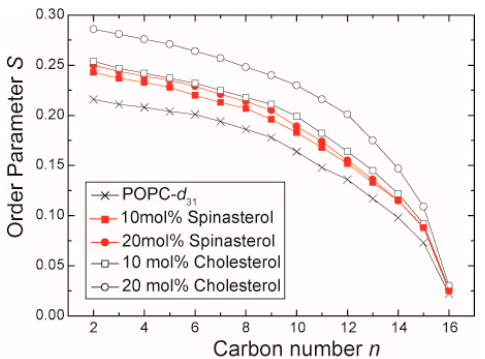
Figure 2. 2 H-NMR chain order parameter of the sn -1 chain of POPC- d 31 in the presence of 10 and 20 mol % α -spinasterol. For comparison, the chain order parameters of pure POPC- d 31 and POPC- d 31 membranes in the presence of 10 and 20 mol % cholesterol are shown (data adopted from [18]). The error of measurement is smaller than the symbol size. Table 1. Lipid chain length calculated according to the mean torque model [20,21].